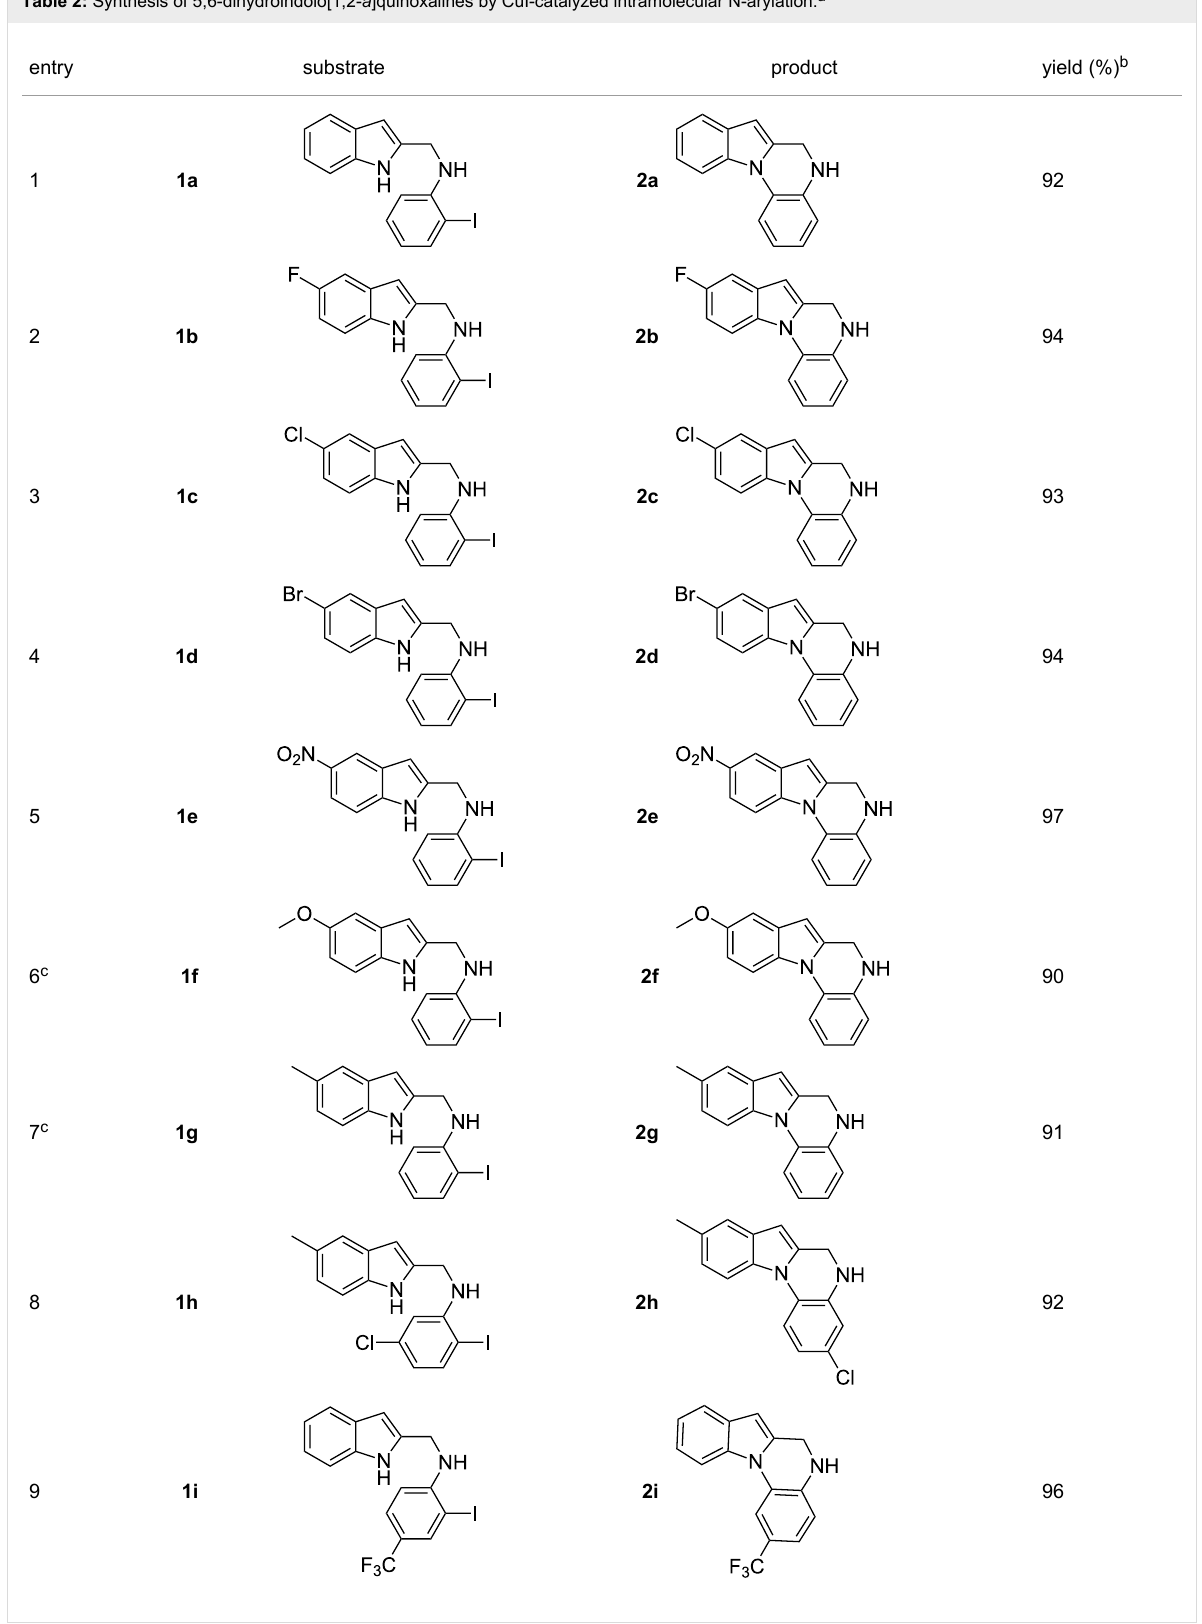
Table 2: Synthesis of 5,6-dihydroindolo[1,2- a ]quinoxalines by CuI-catalyzed intramolecular N-arylation.